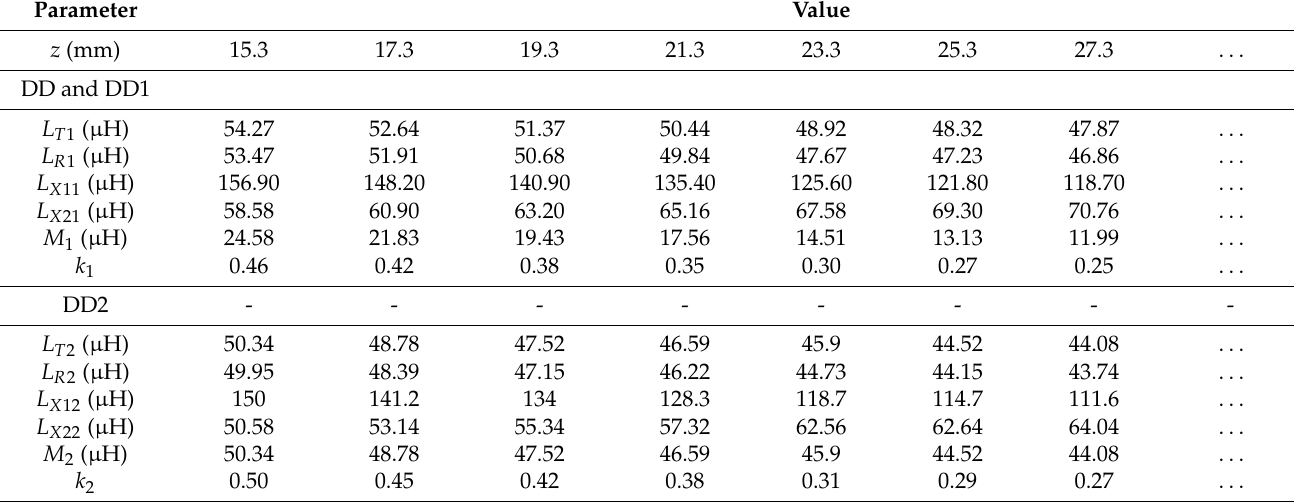
Figure 14. z-axis coupling coefficient measurement: ( a ) single DD coil stucture; ( b ) double DD coil structure. Table 5. Coupling coefficient measurement of the DD1 and DD2 coils in the z axis at x = 0 and y = 0.